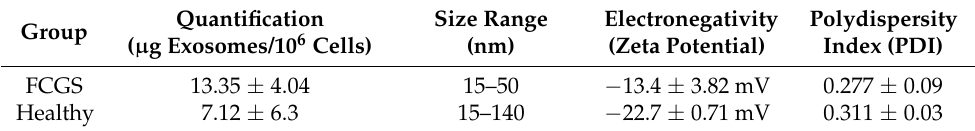
Table 2. Characterization of the isolated exosome samples.